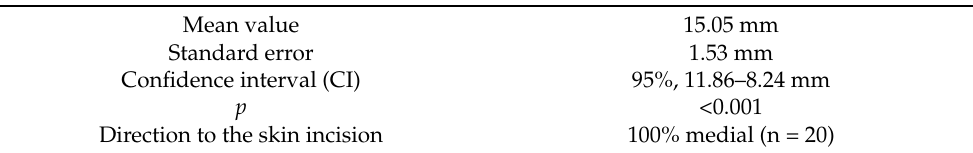
Table 2. Statistical analysis of the measurements concerning the distance of the nerve’s main trunk to skin incision on the right side.